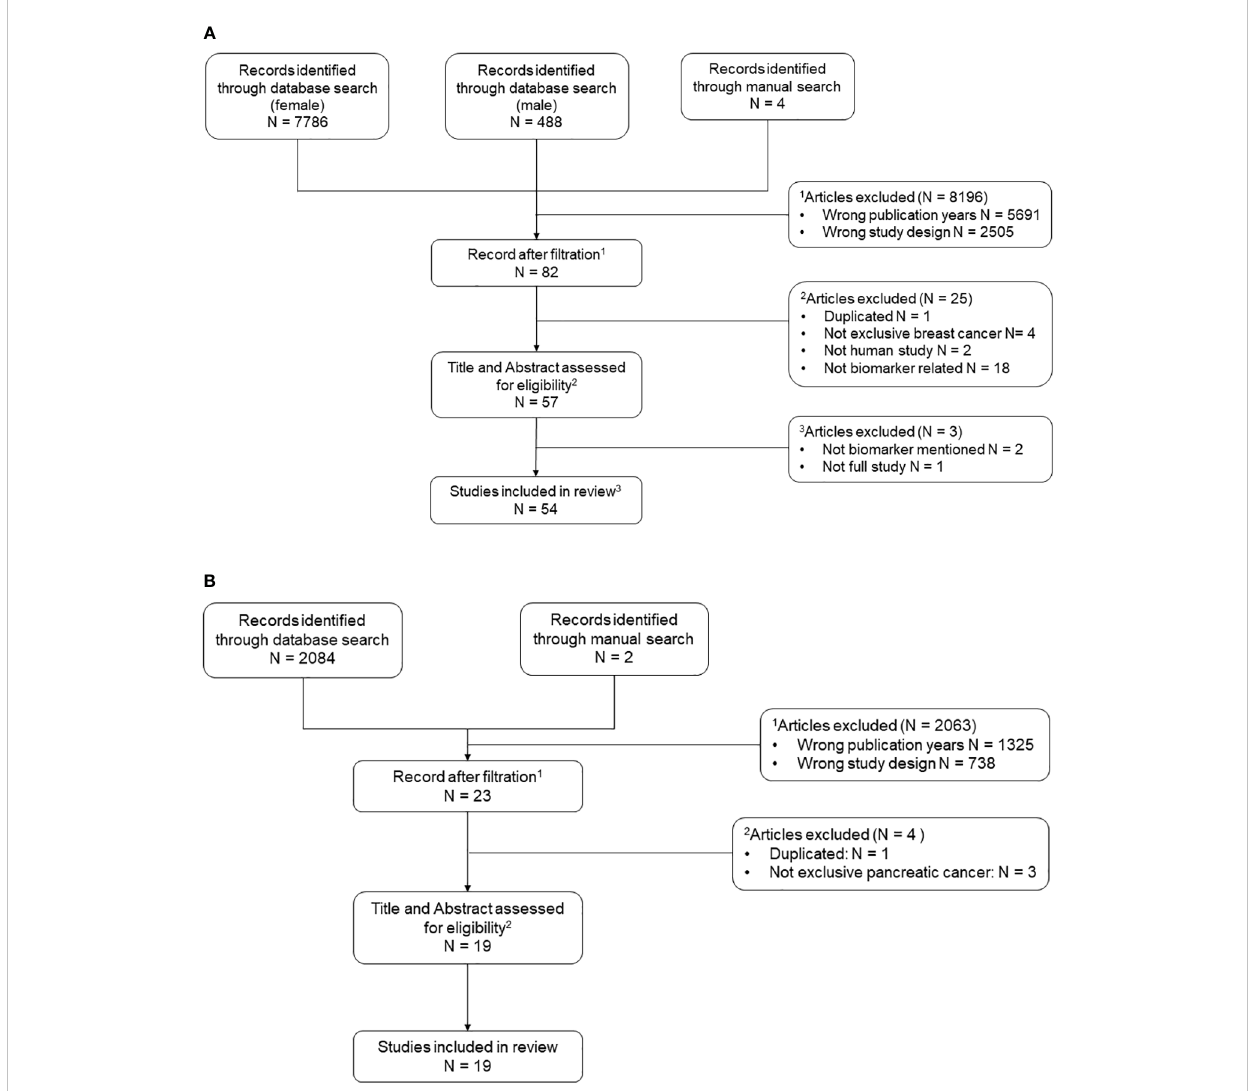
FIGURE 1 Flow chart of systematic literature search process. N is abbreviation for number. A list of relevant key words was curated for both pancreatic cancer and breast cancer using a PubMed mesh term approach. All initial studies retrieved from the three searches (female breast cancer, male breast cancer, and pancreatic cancer) were uploaded to Covidence for title and abstract screening. Two additional rounds of full text data abstraction and quality control were performed. (A) Includes reference selection process for female and male breast cancer. (B) Includes reference selection process for pancreatic